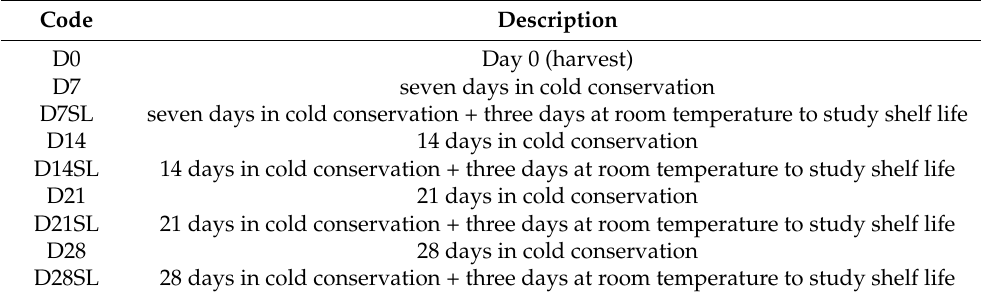
Table 1. Description of samples of O. ficus-indica (L.) Mill analyzed in this study. Code